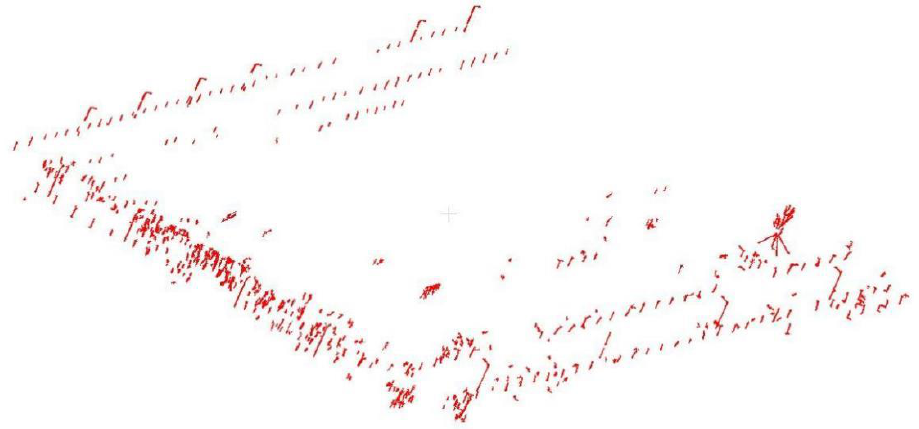
Figure 8. Tree trunk extraction by the GDRG algorithm.